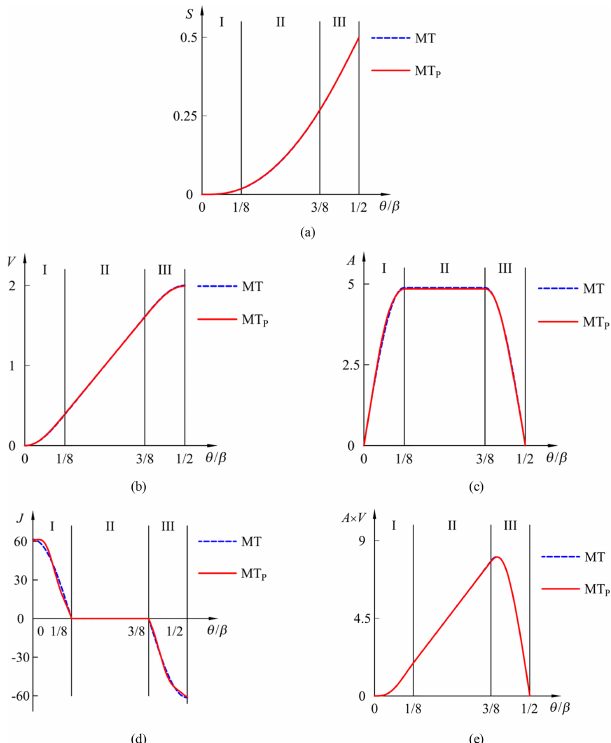
Figure 9. Variation in normalized motion program in Example